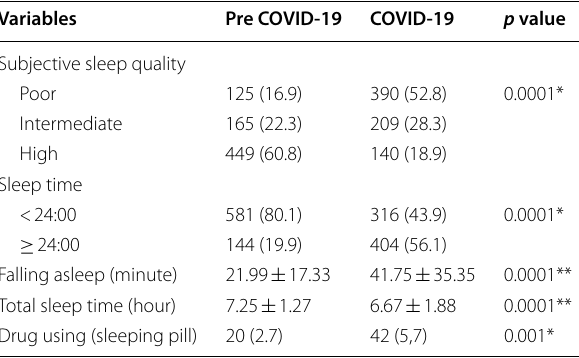
Table 2 Sleep parameters of healthcare workers before and after